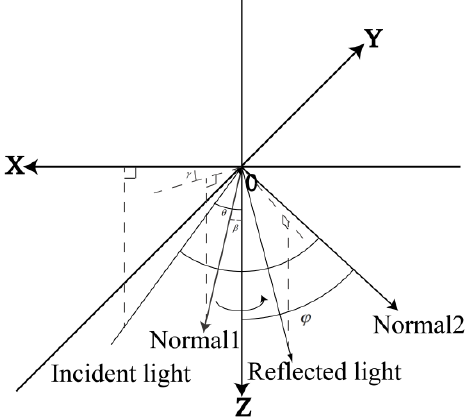
Figure 4. Geometric model of the relationship between the incident light and reflected light in THz rotation mirror imaging system.